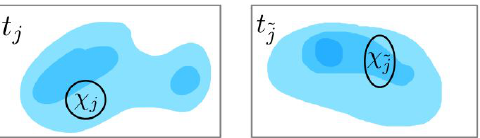
Figure 2. Measurement of the bacteria density (blue) at two different measuring times t j , t ˜ location of the test functions is indicated by the support in space of the test functions χ j , χ ˜